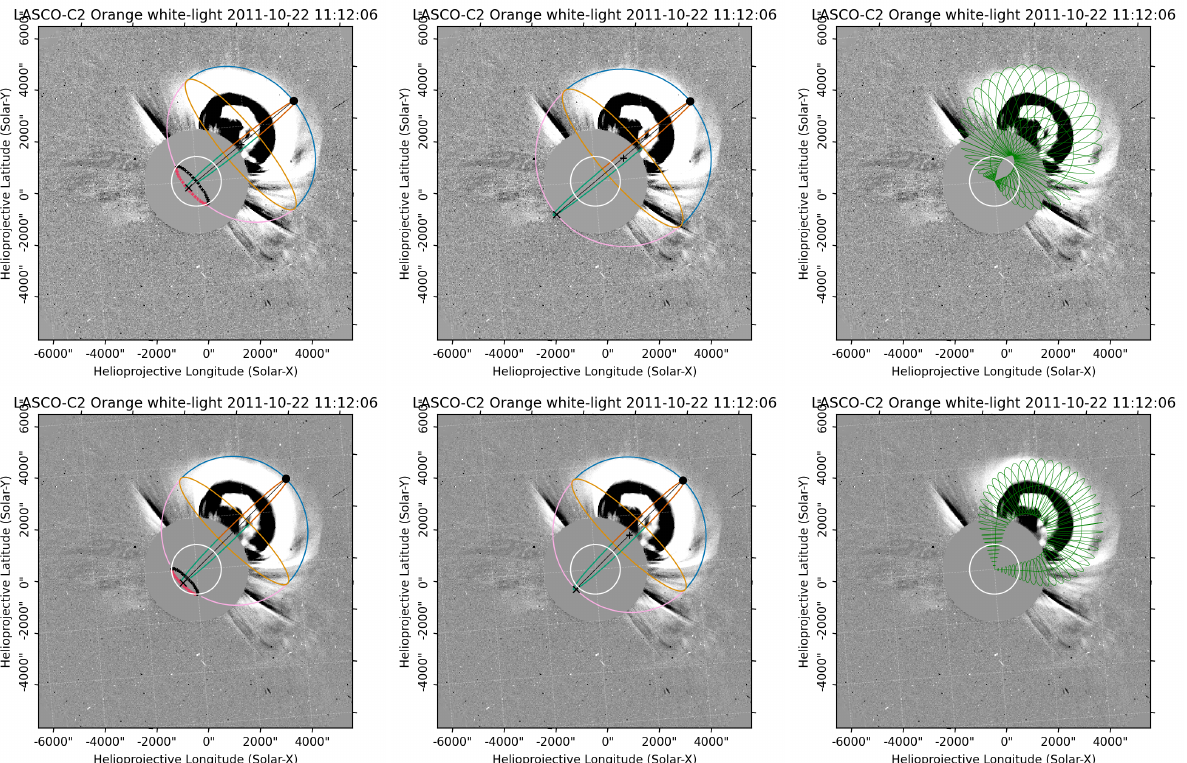
Figure 1. Three-dimensional reconstructions of a CME (E03) using the spheroid ( left ), ellipsoid ( middle ) and GCS model ( right column) from the PyThea tool performed by observers 1 and 2 (top and bottom rows,